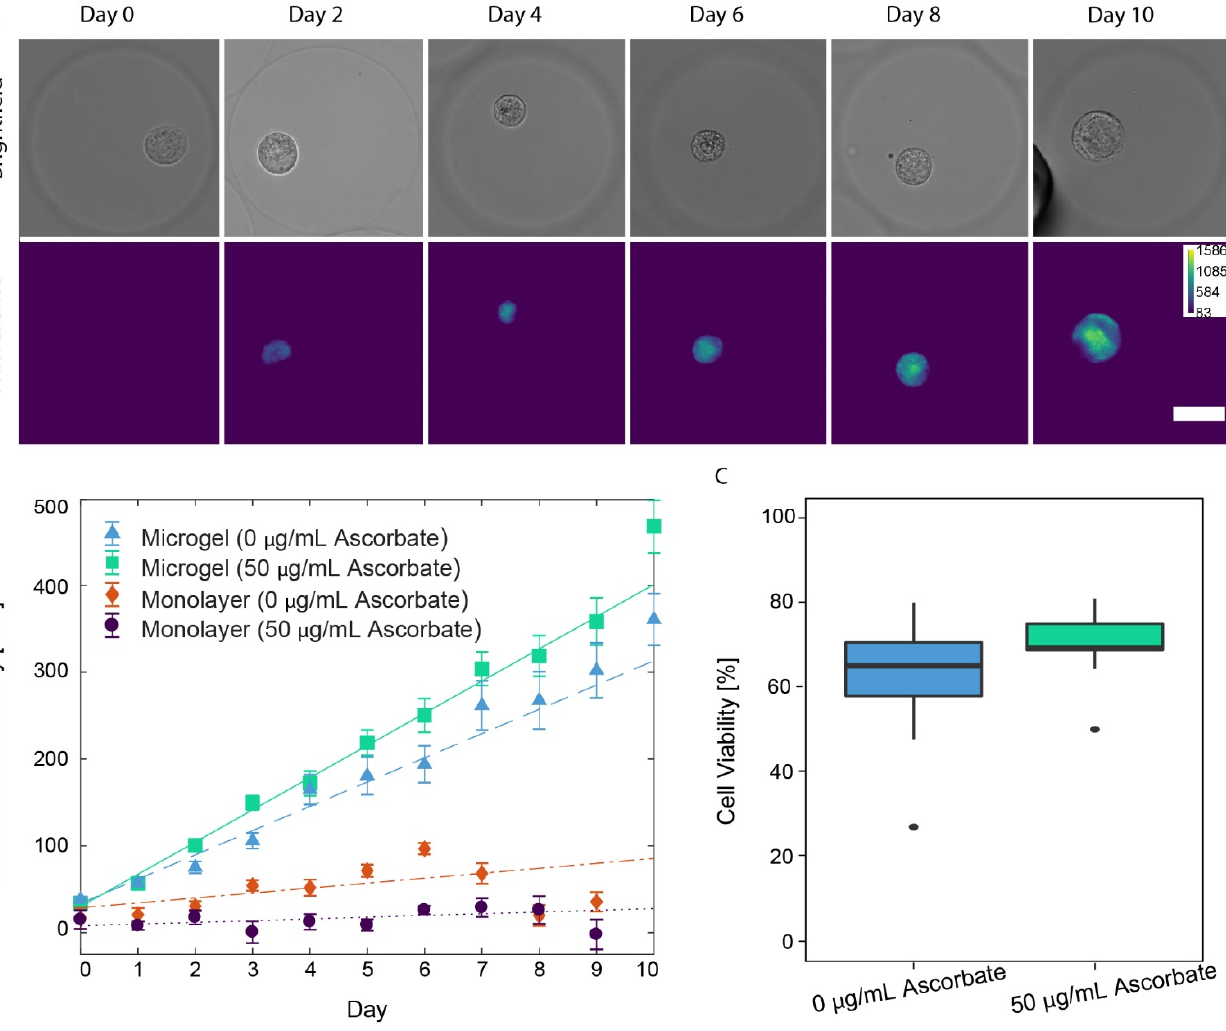
Figure 3. ( A ) Brightfield and fluorescence images (ex. 350/em. 470) of SW1353 cells encapsulated in alginate microgels and cultured with 50 μ g/mL ascorbate. Scale bar is 25 μ m. ( B ) Measured mean fluorescence intensities of imaged SW 1353 cells plotted with a weighted multiple linear regression. SW1353 cells encapsulated in microgels cultured without ascorbate (blue triangle, dashed), encapsulated in microgels cultured with ascorbate (green square, solid), monolayers cultured without ascorbate (orange diamond, dashed–dotted), and monolayers cultured with ascorbate (purple circle, dotted). ( C ) Ten-day cell viability for SW1353 cells encapsulated in alginate microgels. Cell viability between cells cultured with or without ascorbate in microgels did not vary ( p -value = 0.0957).